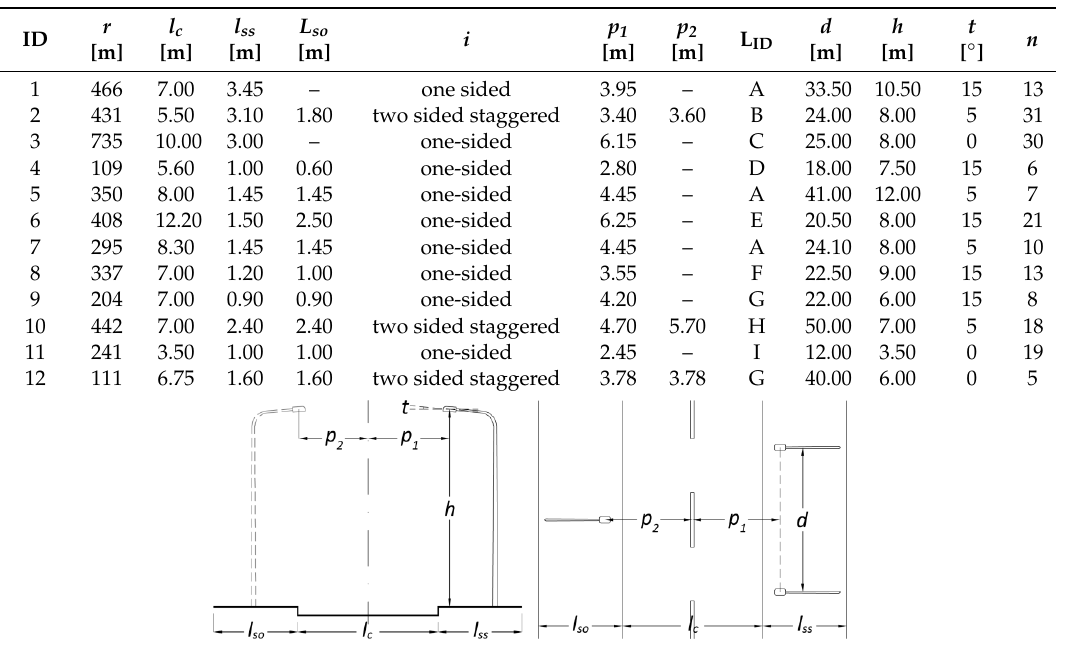
Table 5. Road geometric characteristics and luminaires arrangements data for the 12 analysed roads at the present status. The following symbols are used; ID: road identification number; r : road length; l c :